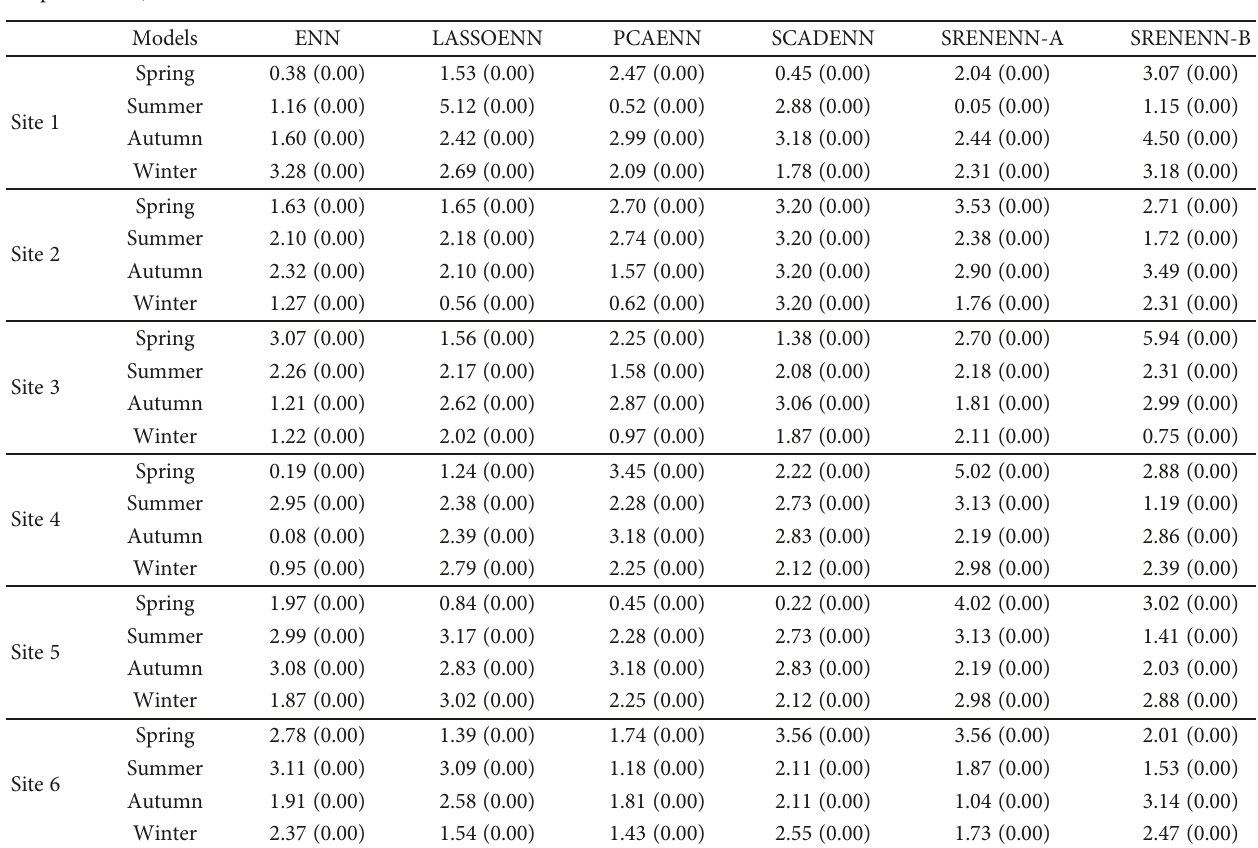
Table 8: The results of Wilcoxon signed-rank tests between SRENENN-B and other competitors for each season at Sites 1 – 6 ( p values are in the